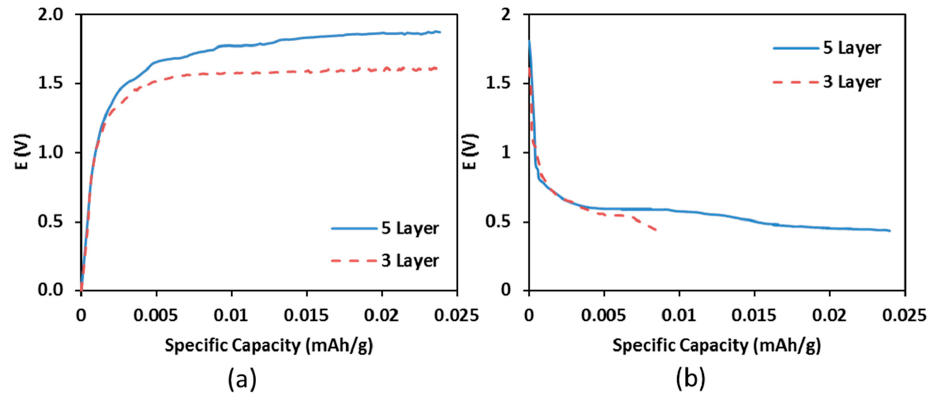
Figure 3. Galvanostatic test results: ( a ) charge curves; ( b ) discharge curves.